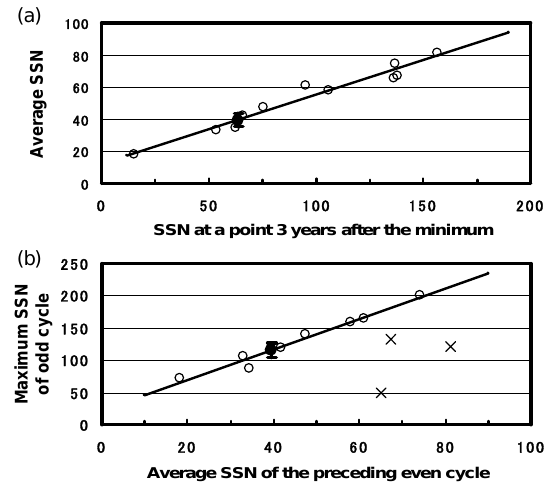
Figure 5. (a) Scatterplot of average SSN versus SSN 3 years af- ter the minimum for even-numbered cycles. The estimated average SSN for cycle 24 is represented by a solid circle with a bar of 1- σ range. (b) Scatterplot of maximum SSN of odd-numbered cycles versus average SSN of the preceding even-numbered cycles. A solid circle shows the value of the predicted maximum SSN of cycle 25.